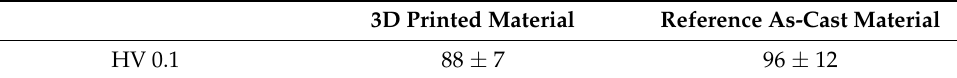
Table 2. Vickers hardness HV0.1 (20 measurements) of the 3D-printed material and as-cast refer- ence material.